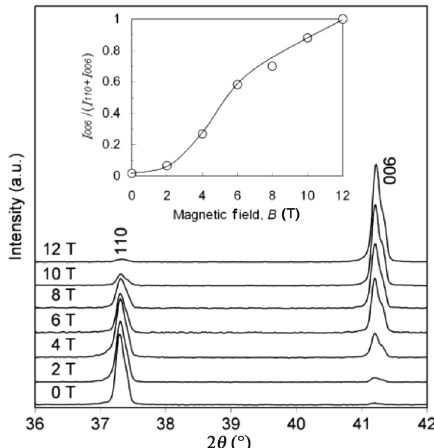
Fig. 19 Effect of magnetic intensity on (110) and (006) diffraction peak intensities and orientation factors of α-Al 2 O 3 specimen surfaces perpendicular to the magnetic field. Reproduced with permission from Ref. [132], © Springer Science+Business Media, LLC